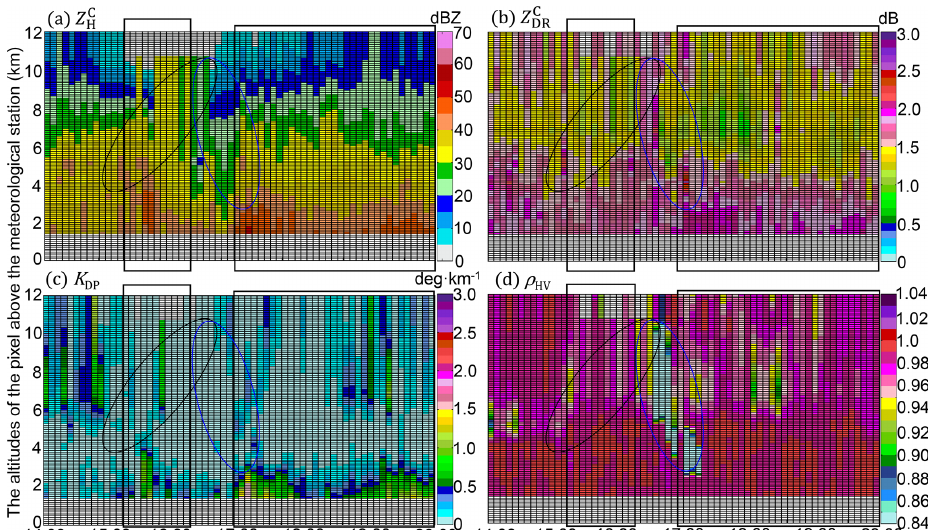
Figure 13. The same as Fig. 12 but for the YH